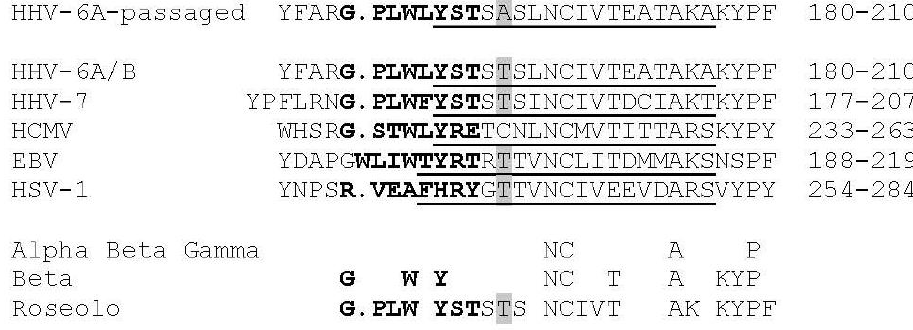
Figure 2. Human herpesvirus gB fusion loop 2, FL2, region sequence comparisons show unique SNP substitution in passaged HHV-6A virus. Comparison of the FL2 (in bold) and associated sequences of HHV-6A gB (residues 184–191 in FL2 in bold) from passaged virus (and cultured BAC virus) compared to gB from 51 clinical samples of HHV-6A/B [45], CiHHV-6A/B [14,24], and 50 clinical samples of HHV-7 gB [46] demonstrating the Thr193Ala mutation is only found in passaged virus. This is compared to reference sequences from alpha, beta, and gamma herpesvirus gB where the structure has been determined, as shown for HCMV gB structure, identifying the beta sheet 12 in domain I [40]. Alignments were made using Clustal as described [40] with gB from HCMV (shown for strains Merlin, Towne, and TB40E and 74 clinical strains; strain AD169 and six clinical strains have Val252Leu), EBV (strain B958), and HSV-1 (strain KOS) (UniProtKB P06473, Q777B0, P06437, respectively). The FL2 in HCMV, EBV, and HSV-1 gB are in bold, and predicted FL2 for HHV-6A/B and HHV-7 are similarly indicated. FL2 in HHV-6A/B gB is amino acids 184–191 and in HCMV, strain Merlin, 237–244. This is adjacent to a conserved beta sheet shown in the structures of EBV, HSV, and cytomegalovirus (CMV) gB as underlined, and that predicted for HHV-6A/B and HHV-7 indicated (See Methods). The Thr193Ala passage SNP is shaded in the FL2 adjacent region, disrupting the polar patch and increasing hydrophobicity. This Thr is conserved in HHV-6A/B, HHV-7, EBV, and HSV.